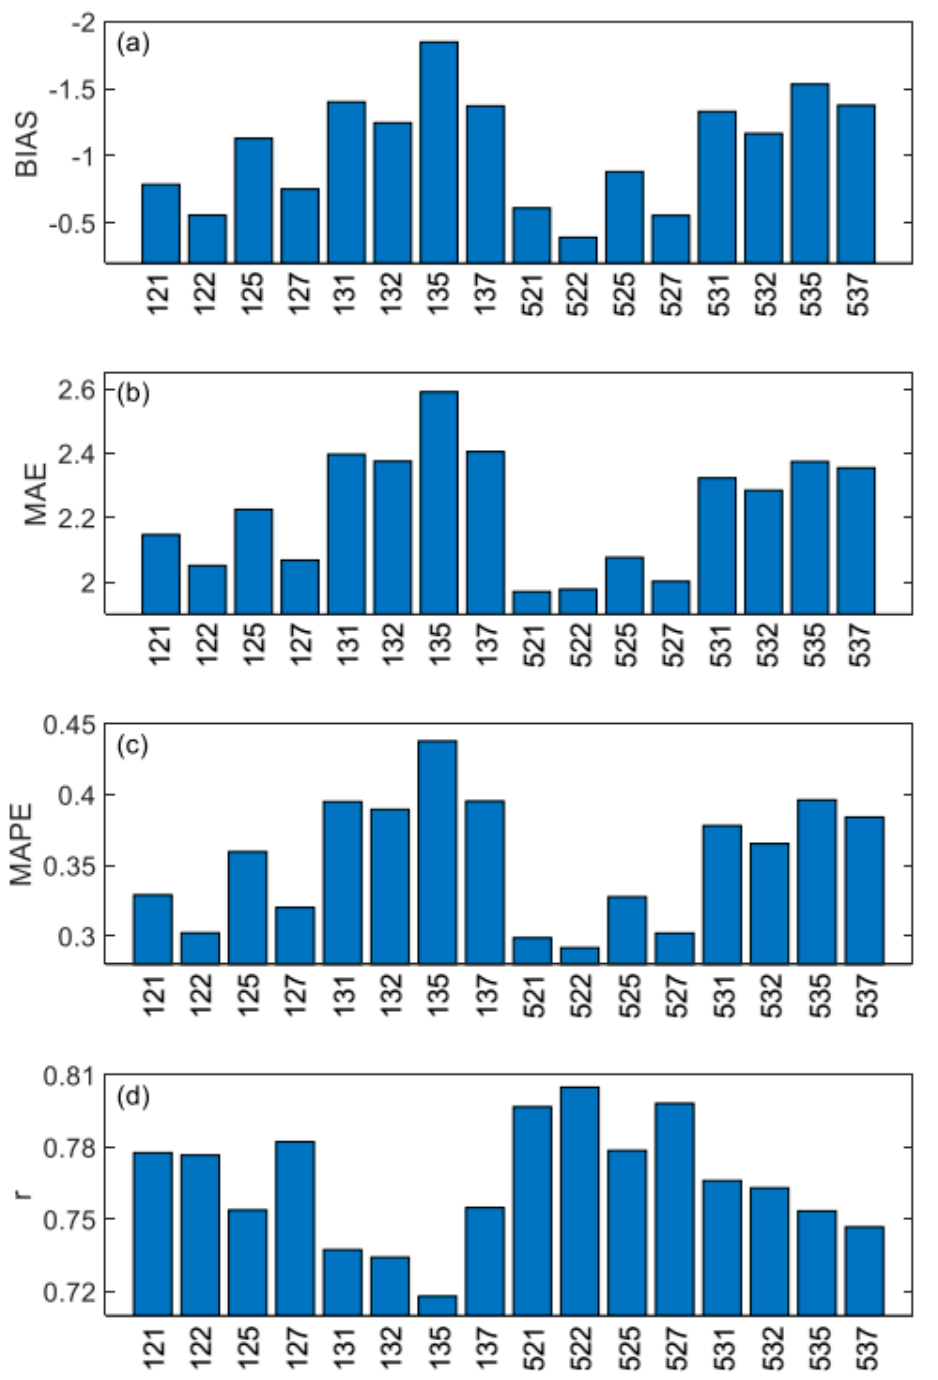
Figure 8. Histograms of BIAS, MAE, MAPE, and r calculated for domain D4 and 16 simulations: ( a ) BIAS; ( b ) MAE; ( c ) MAPE; ( d ) r .